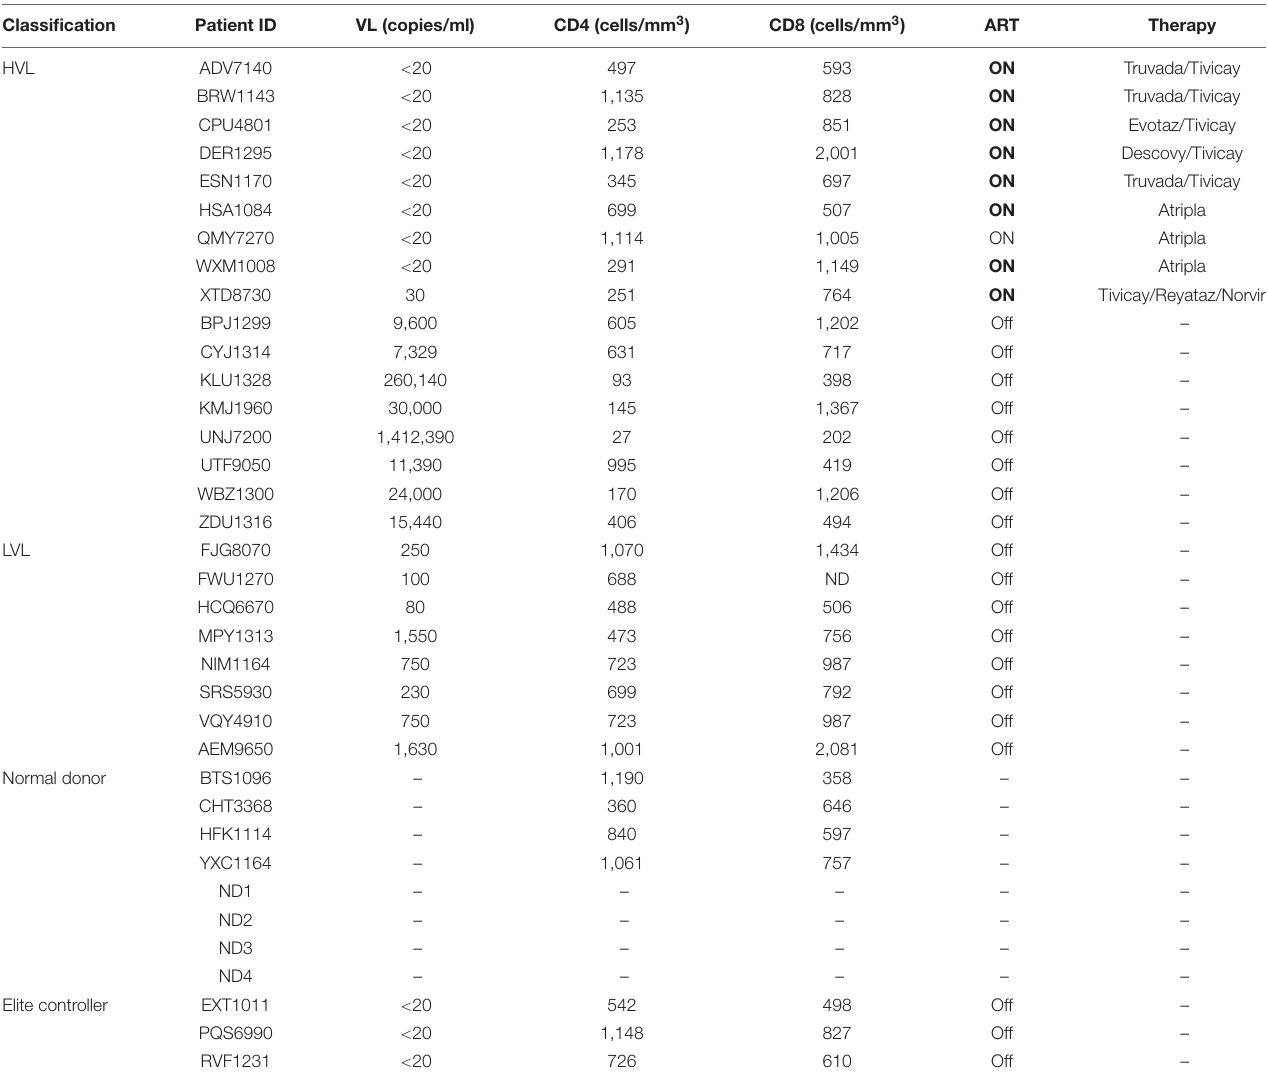
TABLE 1 | Human subject classifications and clinical information.